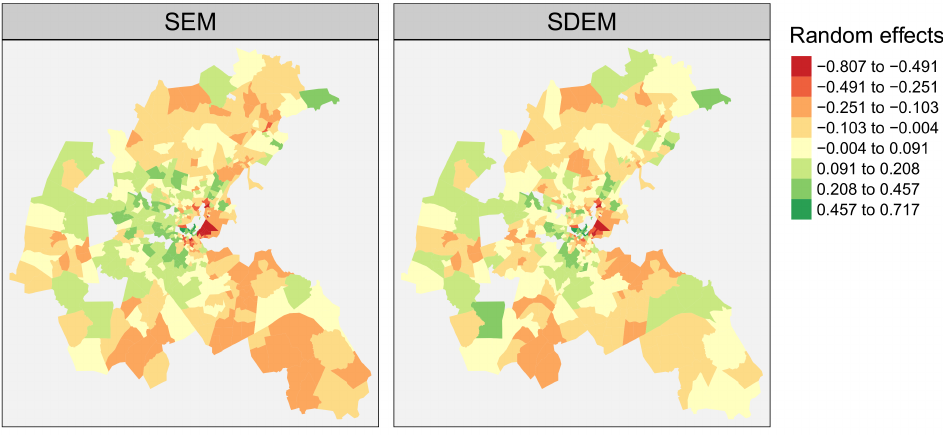
Figure 2. Posterior means of the slm latent effects for the SEM and SDEM, Boston housing